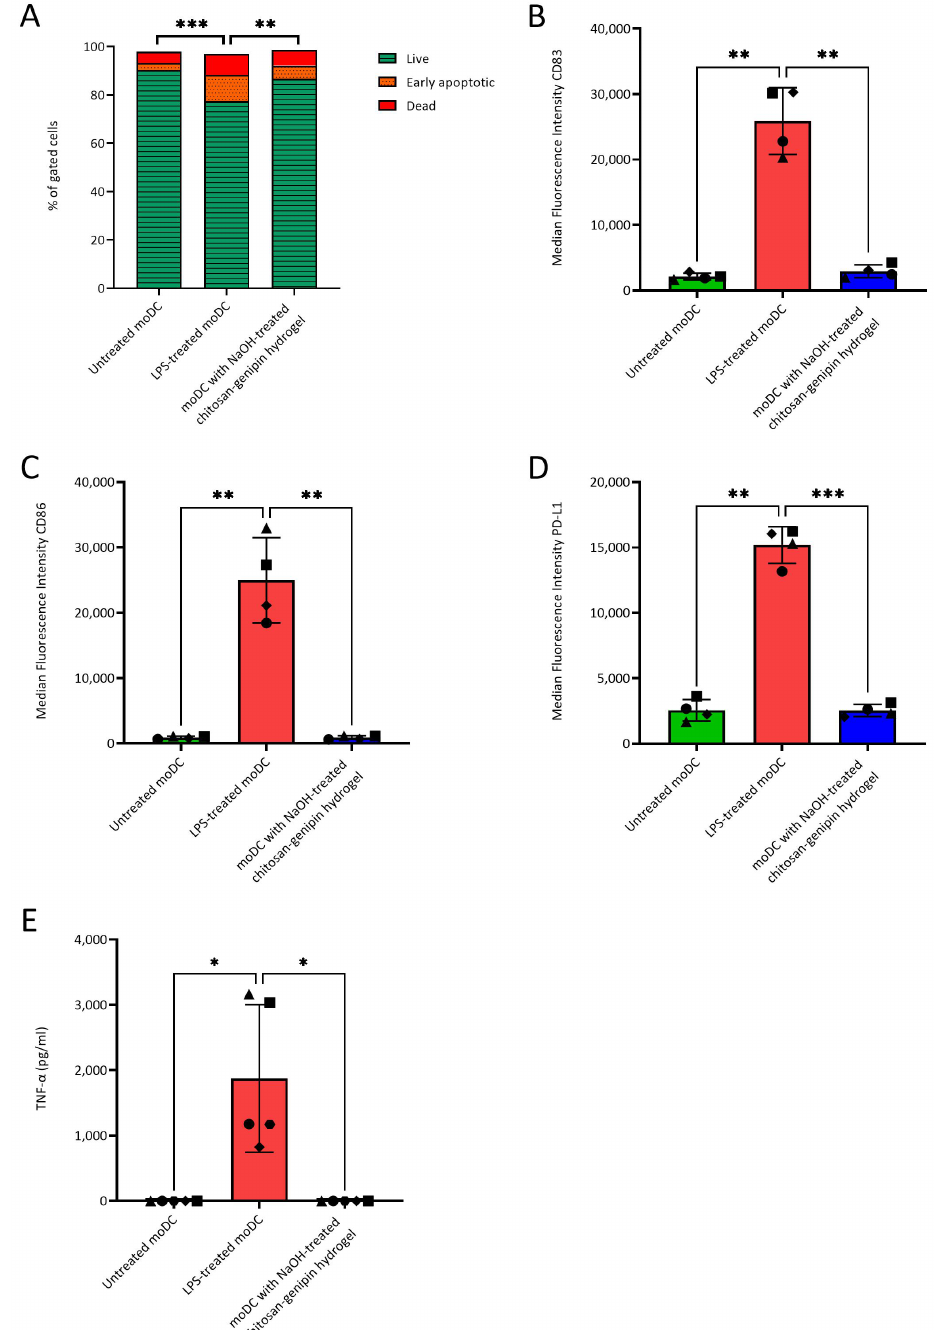
Figure 6. Viability of moDCs cultured without LPS, with 100 ng/mL LPS or with hydrogels made from NaOH-treated chitosan and genipin for 24 h ( A ). Median fluorescence intensity of the maturation markers CD83 ( B ), CD86 ( C ) and PD-L1 ( D ) of moDCs cultured without LPS, with 100 ng/mL LPS or with hydrogels, N = 4. TNF- α production of moDCs cultured without LPS, with 100 ng/mL LPS or with hydrogels ( E ). N = 5 (each symbol represents a different donor). * p < 0.05; ** p < 0.01; *** p <